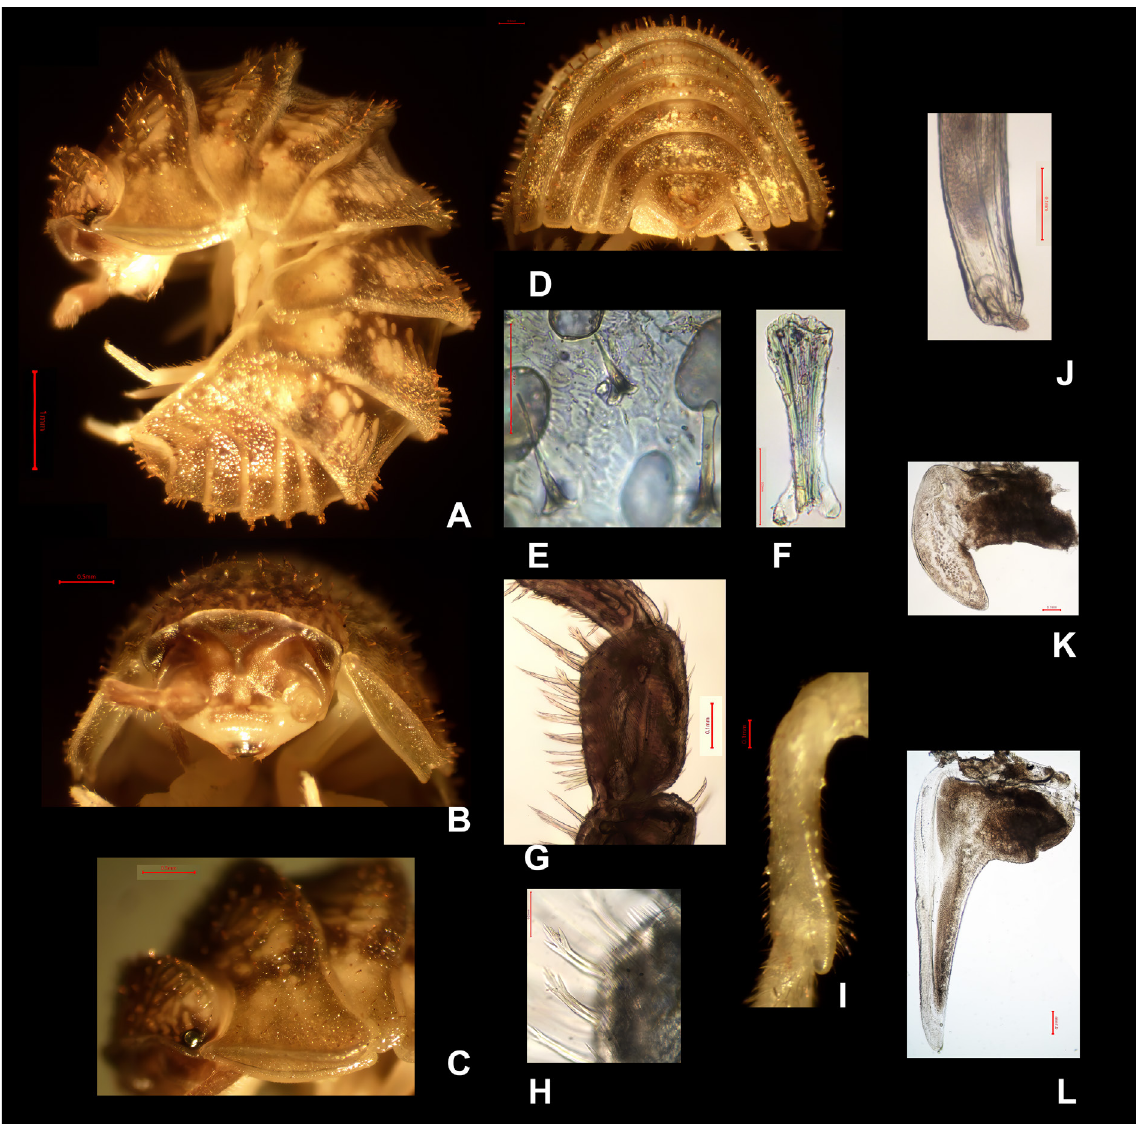
Fig. 3. Eluma matae sp. nov., paratype, ♂ (INV16006). A . Habitus, side view. B . Cephalon and first pereonite, frontal view. C . First pereonite, side view. D . Pleon, telson and uropods. E . Dorsal tegument and scale-setae. F . Scale-setae, detail. G . Carpus of the pereopod 1. H . Carpus of the pereopod 1, setae. I . Pereopod 7, ischium. J . Tip of endopod I. K . Exopod I. L . Exopod II. Scale bars: A = 1 mm; B–D = 0,5 mm; E, F, H = 0.05 mm; G, I–L = 0.1